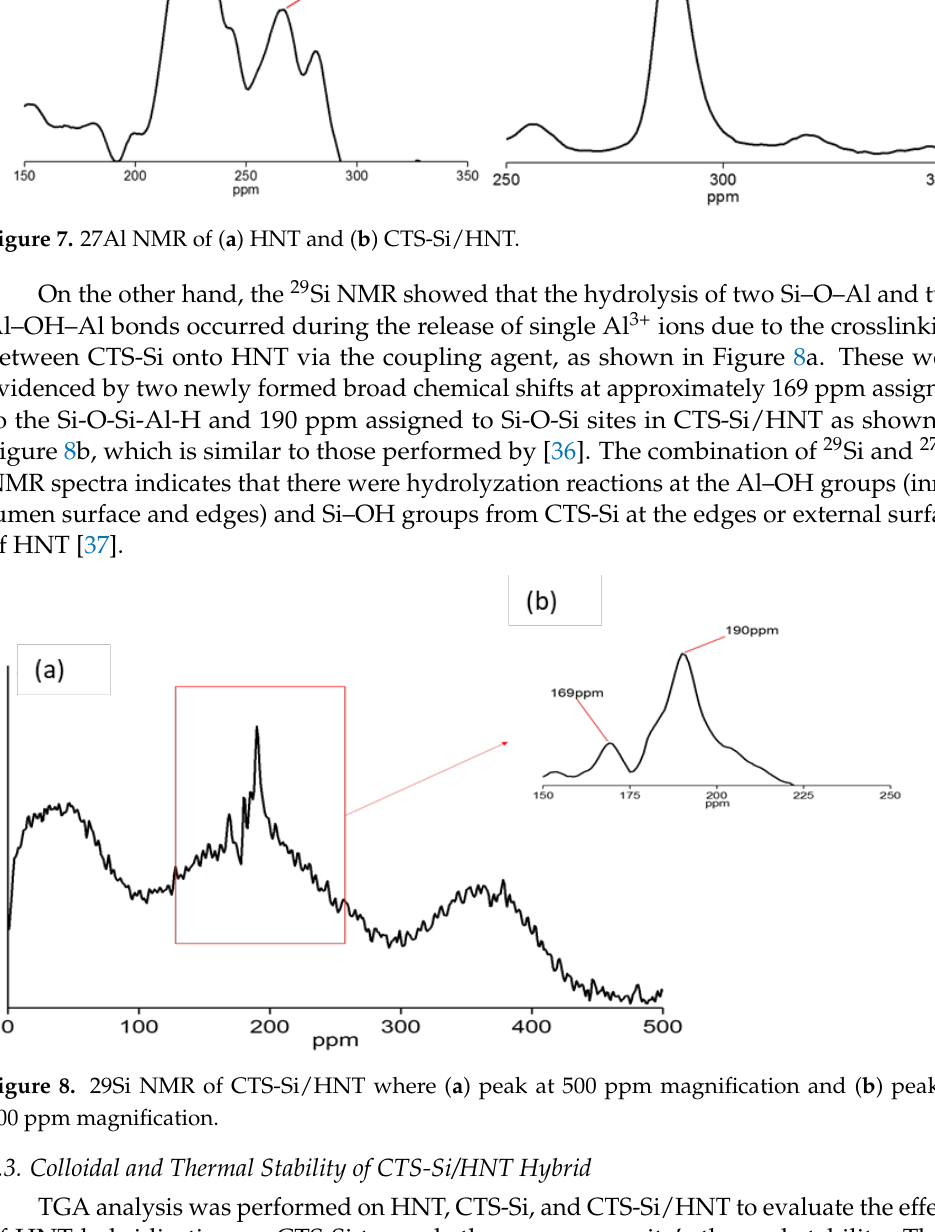
Figure 7. 27Al NMR of ( a ) HNT and ( b ) CTS-Si/HNT.